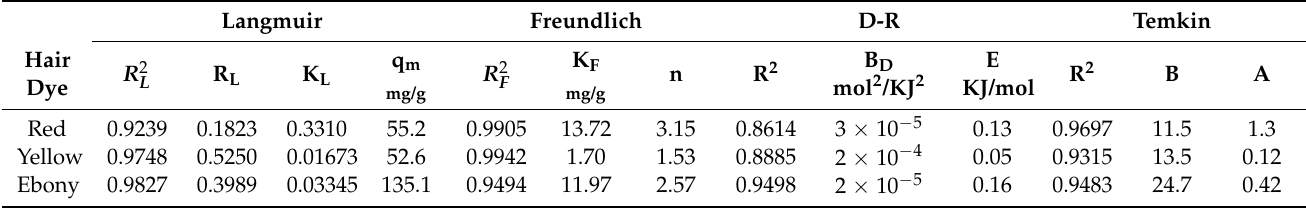
Figure 17. Temkin isotherm of R, Y, and E hair dyes onto COZ. Table 3. Isotherms model constants .